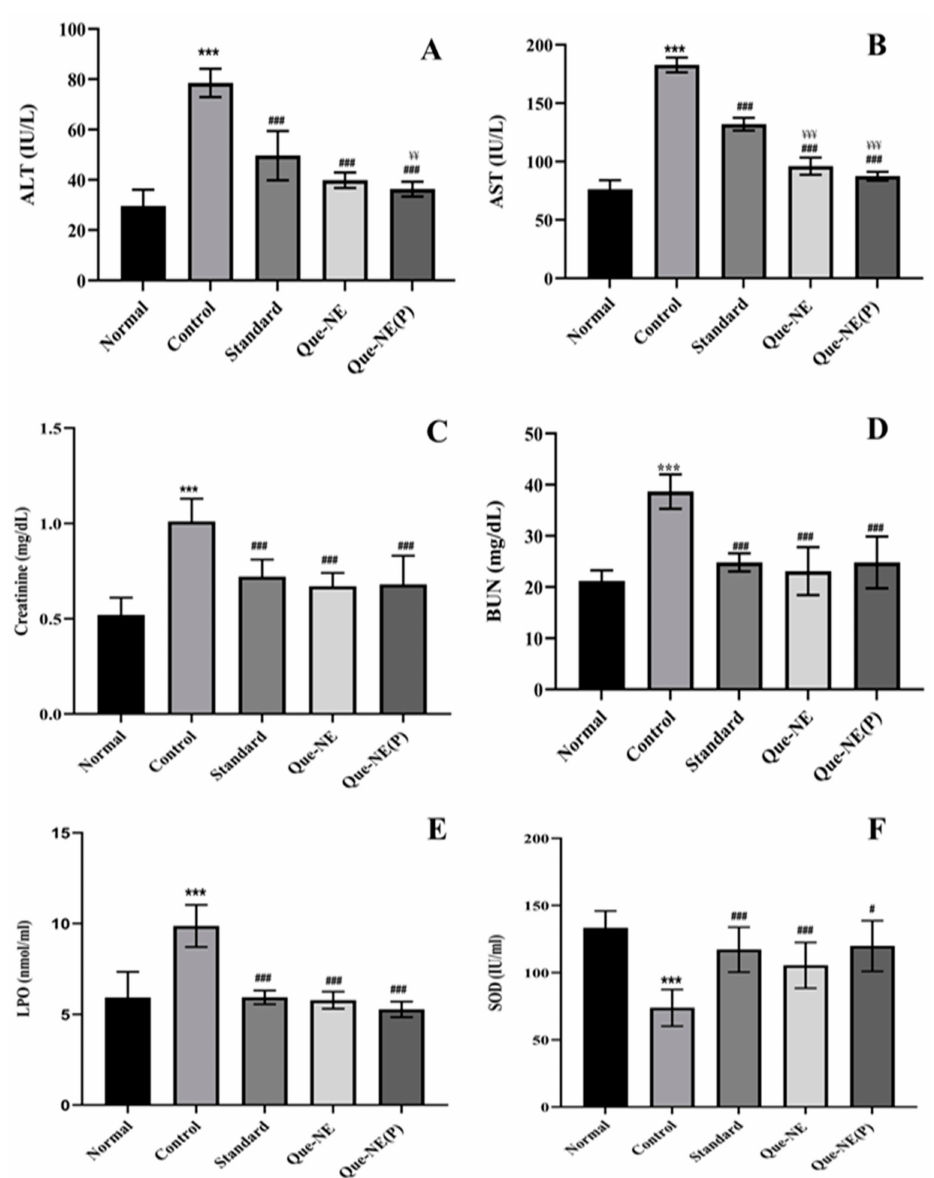
Figure 10. Effect of Que-NE and Que-NE (P) on: ( A ) alanine aminotransferase—ALT; ( B ) aspar- tate aminotransferase—AST; ( C ) creatinine; ( D ) blood–urea–nitrogen—BUN; ( E ) lipid peroxidation; ( F ) superoxide dismutase—SOD. Data presented are the mean ± standard deviation. Significance was measured using one-way ANOVA. *** p < 0.001 vs. Normal group. # p < 0.05, and ### p < 0.001 vs. Control group. ¥¥ p < 0.01, and ¥¥¥ p < 0.001 vs. Standard group ( n =